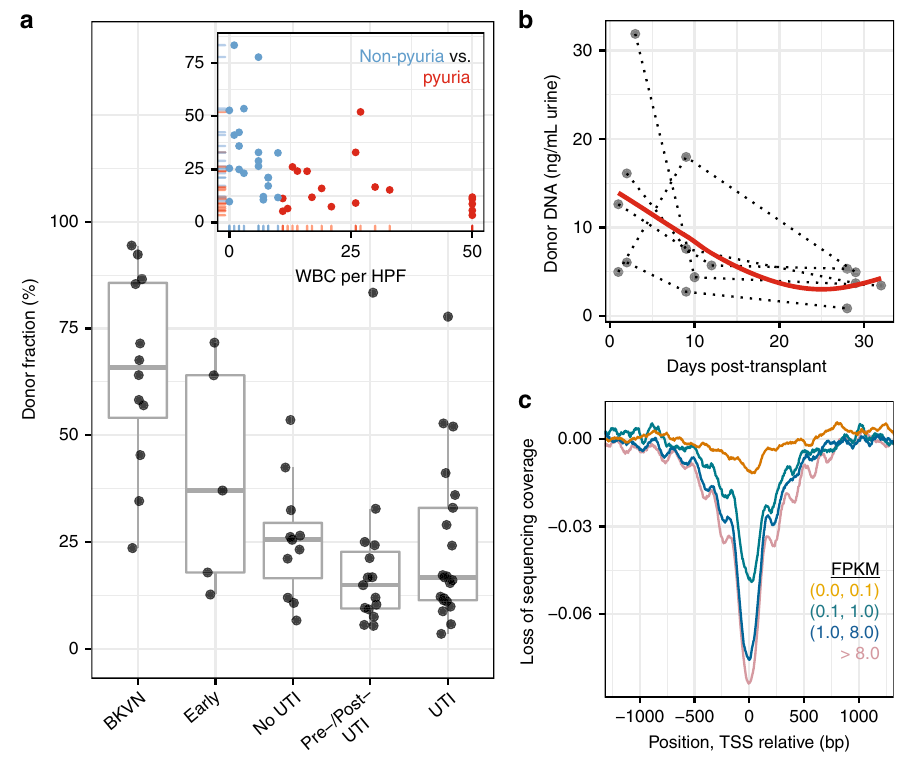
Fig. 5 Quantifying the host response to infection from urinary cfDNA. a Proportion of donor-speci fi c cfDNA in urine of subjects that are BKVN positive per kidney allograft biopsy (BKVN) in urine collected in the fi rst 5 days after transplant surgery (Early), urine collected from subjects that are bacterial UTI negative per culture in the fi rst month following transplantation (No UTI), samples collected before or after bacterial UTI (Pre-/Post-UTI), and samples collected at the time of bacterial UTI diagnosis (UTI). The single outliers in Pre-/Post-UTI and UTI groups correspond to the same patient, who suffered an acute rejection episode in the months prior. Low donor fractions in the Pre-/Post-UTI and UTI groups are likely due to increased immune cell, i.e., WBC, presence in the urinary tract; subjects with higher WBC counts have lower donor fractions (inset, red color indicates pyuria). b Absolute abundance of donor cfDNA in the urine of subjects not diagnosed with infection in the fi rst month post-transplant (red line is a LOESS fi lter smoothing curve, span = 1). Dotted lines connect samples from the same patient. c Genome coverage at the transcription start site, binned by the gene expression level across all samples in the study. FPKM fragments per kilobase of transcript per million mapped reads, an RNA-seq measure of gene expression. See